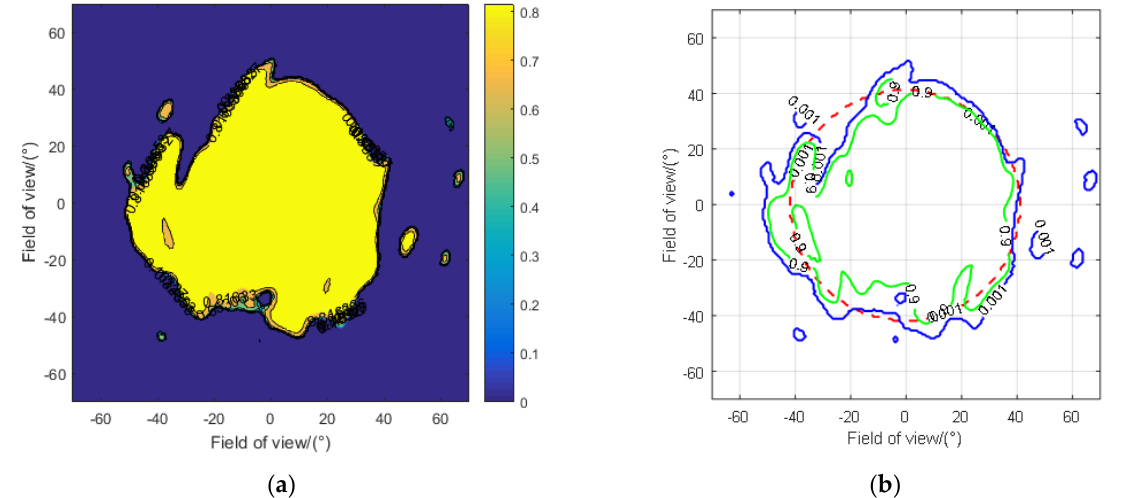
Figure 2. Contour distribution of irradiance on the image plane. ( a ) Contour distribution of normalized illuminance for downwelling radiation from the sky on the image plane. ( b ) Contour distribution of normalized illuminance (the red dashed line is the boundary of Snell’s window in flat water; the blue solid line is the boundary of Snell’s window in wavy water).